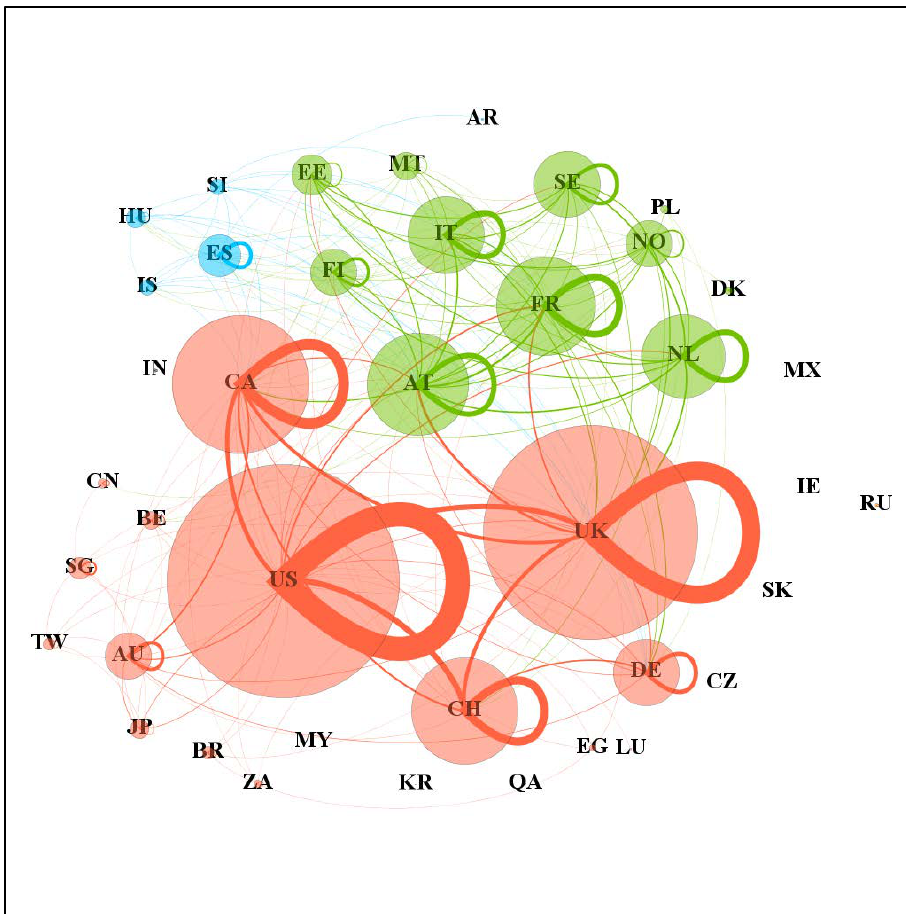
Figure 4. Co-authorship networks visualised in the Gephi 0.9.2 software. Table 1 Top journals, authors, papers, institutions and countries.